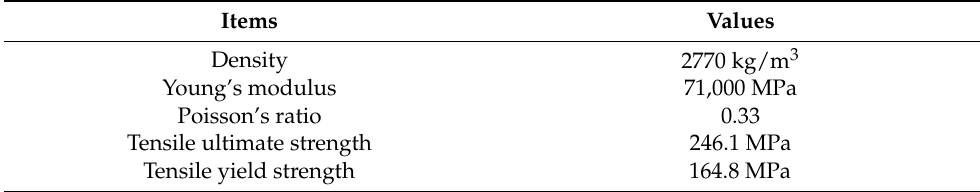
Figure 3. Finite-element model for drop-hammer test. Table 2. Material properties used in FE